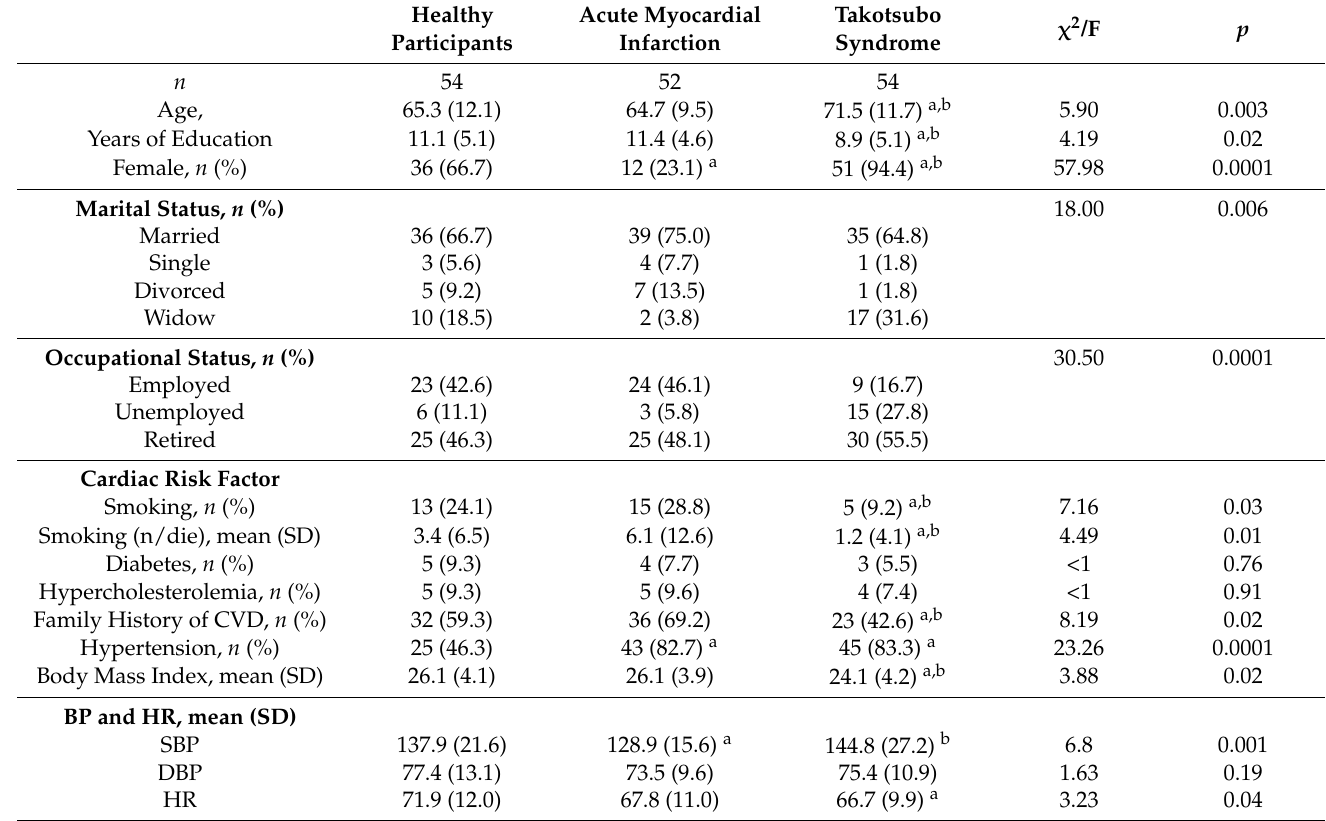
Table 2. Means ( ± SD) of sociodemographic and anamnestic characteristics of the three groups of participants.